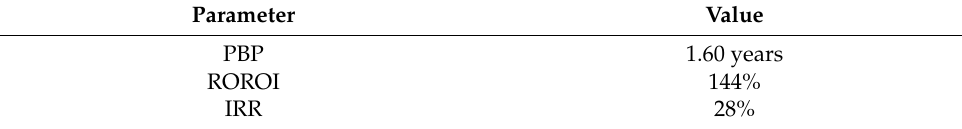
Figure 8. Projected net present value (NPV) of biodiesel production from RSO. Table 9. Summary of investment criteria of biodiesel production from RSO.